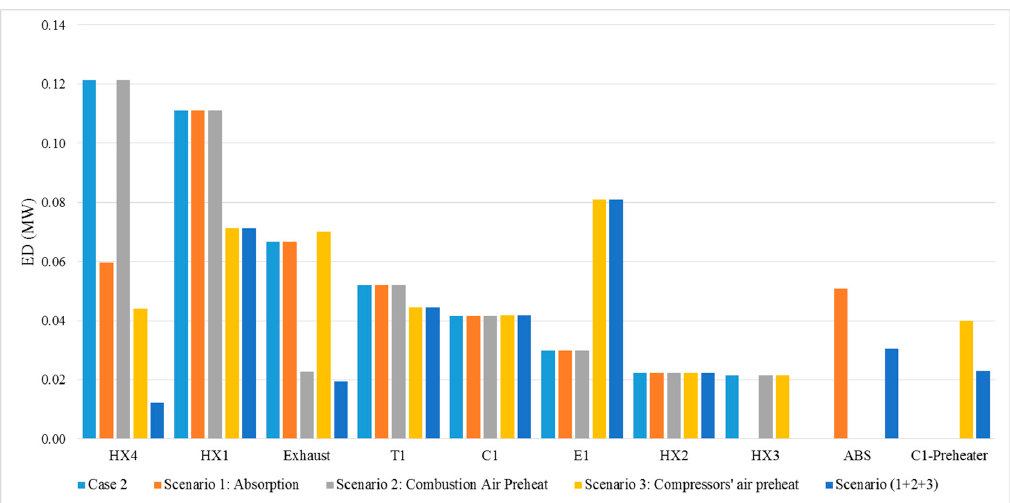
Figure 23. ED in the fired heater and total ED for the considered scenarios.